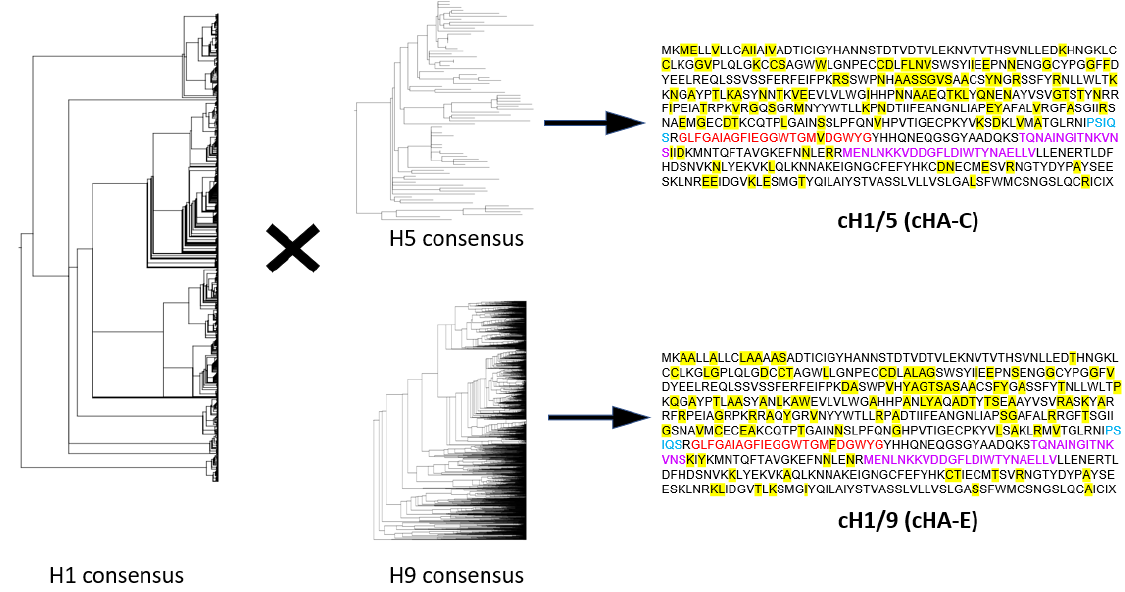
Figure 2. Chimeric HA generation through consensus building of H1 and H5 or H9 HAs. Consensus sequences were generated from H1 (over 1000), H5 (76), and H9 (over 3000) sequences. Sequences from the H5 or H9 consensuses were used to fill in spaces within the H1 consensus to generate two chimeric HA molecules: cHA-C (cH1/5) and cHA-E (cH1/9), respectively. These chimeras reveal both the conserved sequences (repre- sented as amino acids in black fonts) and polymorphic sites (represented by the yellow highlighted sequences serving as areas into which H5 or H9 sourced amino acids were introduced) of the H1 HA. The cleavage site (blue fonts), fusion peptide (red fonts) and heptad repeats (purple fonts) are key conserved regions. 3.2. cHAs Are Relatively Similar in Structure and Function to A Typical HA Structural predictions of each of the cHAs by the I-TASSER online platform indicated about 80% structural similarity as well as a 70% potential to be similar in function as an influenza HA. These predictions were based on TM-scores, which predict structural sim- ilarity to a hit protein template, and C-scores, a parameter that predicts that the likelihood of function of the protein being assessed (Table 1 and Figure 3). Model structures pre- dicted were similar to an HA type 16 (a type which categorizes with group 1 HAs, where H1 HA is a member) crystal structure (42f3) in the Protein Database [33]. Sequence anal- yses and visualization of the structure was by aid of Pymol [34], the platform that also afforded the visual representation of key amino acid substitutions within the specific re- gions of the receptor binding domains of the cHAs: “G/E/D/N/158 L” for cHA-C, and “G/E/D/N/158 L and K/N163 P” for cHA-E (as illustrated in Figure 3). Further protein alignment using the Basic Local Alignment Search Tool (BLASTp) [35] of cHA-C and cHA- E, generated 85% and 82% similarities, respectively, to the HAs of A/swine/Tian- jin/01/2004 (H1N1) and A/Taiwan/01/1986 (H1N1) viruses, confirming that both con- structs are not of any random influenza virus subtype, but predominantly HA of the in- fluenza H1 subtype.